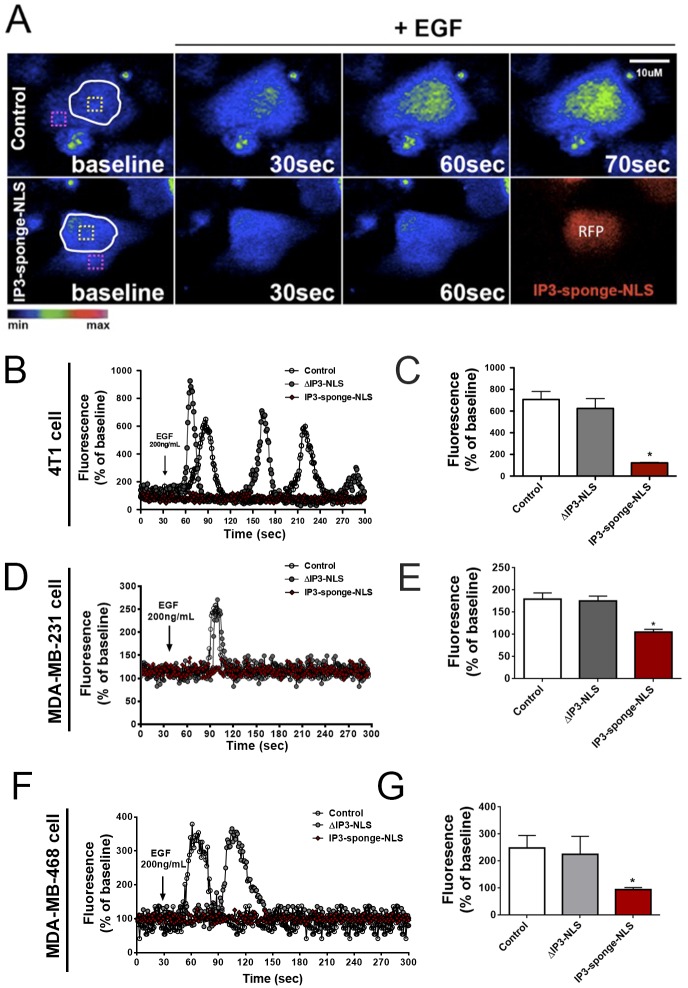
Nuclear IP3 buffering decreases Ca+2 signals in the nucleus of triple negative breast cancer cells.(A) Confocal serial images of control (top panels) or IP3-sponge-NLS infected 4T1 cells (bottom panels), loaded with fluo-4/AM and stimulated with 200ng/ml EGF for 30, 60 and 70 seconds. Dashed yellow boxes represent the nuclear region of interest. Images were pseudocolored according to the scale shown at the bottom. Scale bar = 10μM. (B, D and F) Representative time course of nuclear fluorescence levels of 4T1, MDA-MB-231 and MDA-MB-468 cells, respectively. Black arrow indicates initial EGF stimulation and fluorescence level is expressed as % of basal fluorescence. (C, E and G) Average nuclear fluorescence peak (n = 20 cells) of each cell group and condition throughout the time-course; fluorescence level is expressed as % of basal fluorescence. * = p <0.05 versus control. Values are expressed as mean ± SD.